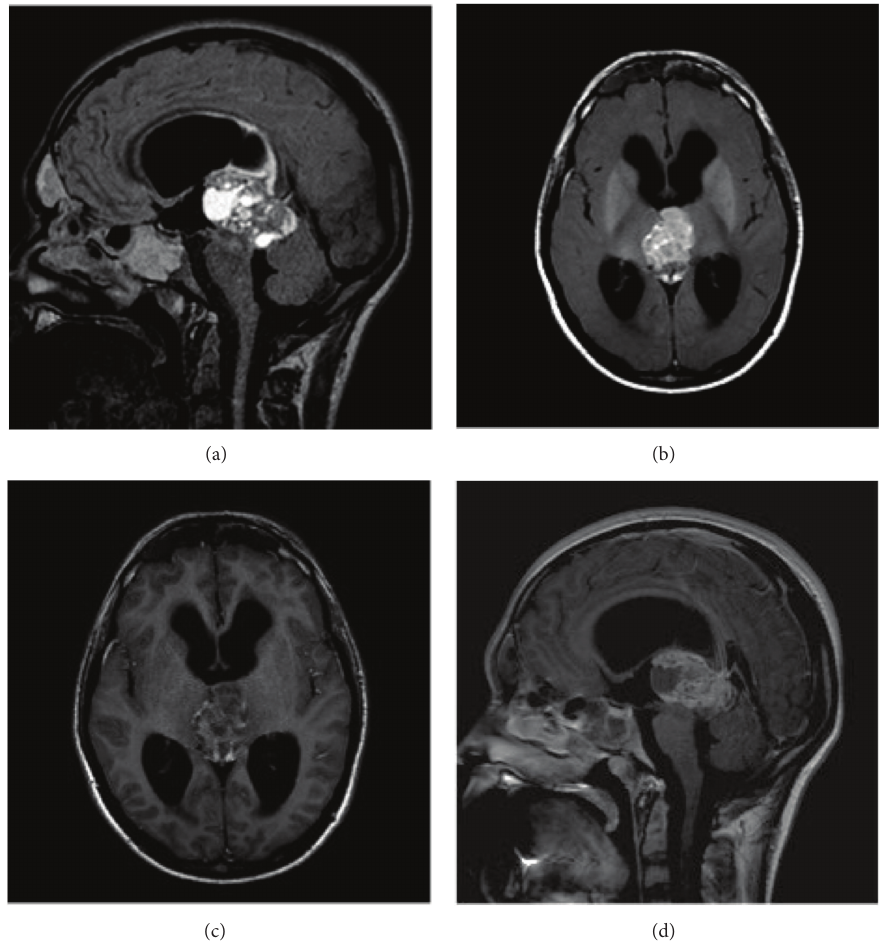
Figure 1: Sagittal FLAIR (a) shows solid and cystic portions, both containing high protein content. Axial T1 SE/MTC (b) shows more pronounced hyperintensity than the comparative T1 SE (c). T1 SE after gadolinium administration (d) confirms heterogeneous enhancement in the solid portion of the tumor and the cystic